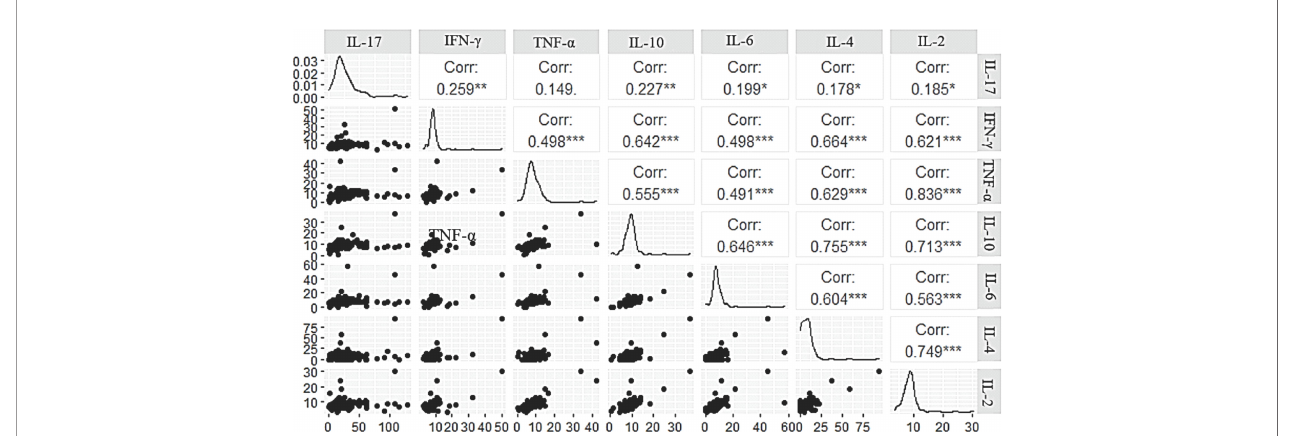
FIGURE 5 | Correlogram of cytokine levels evaluated in long COVID-19. *p<0.01; **p<0.001